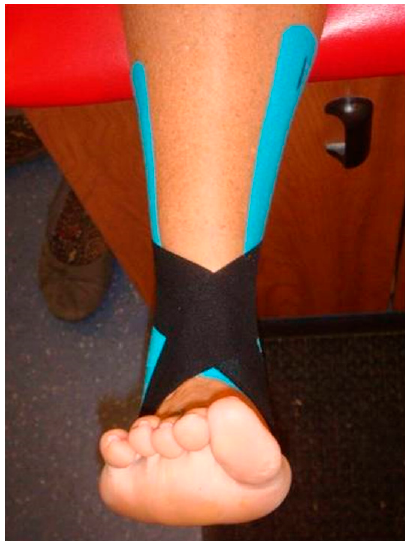
Figure 6. Anterior view of the third strip of Kinesio tape.